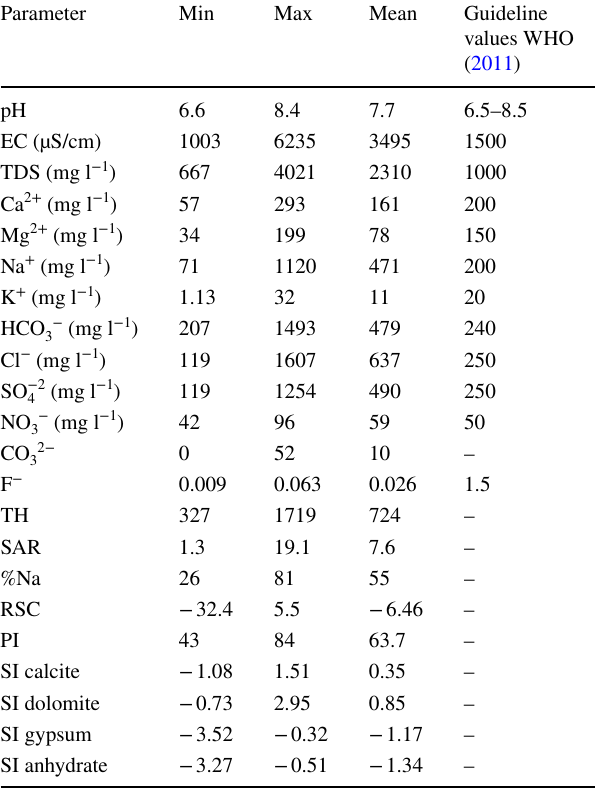
Table 3 Summary statistics of the analytical data and groundwater samples of the study area exceeding the permissible limits prescribed by WHO for drinking purposes